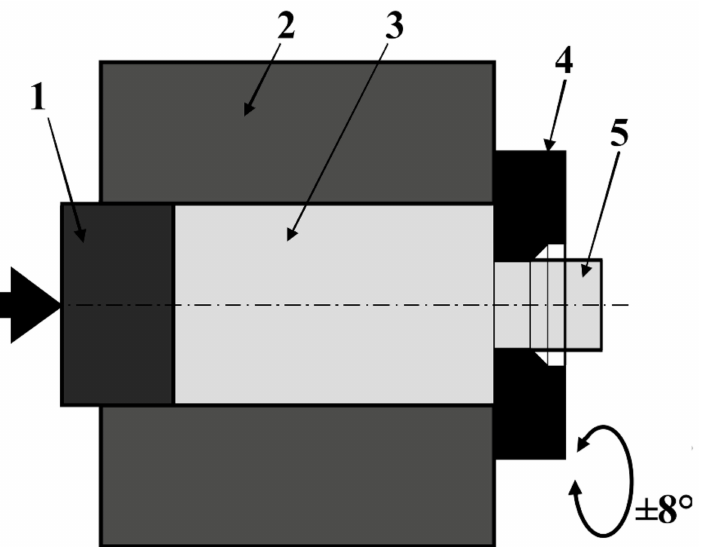
Figure 1. Scheme of KOBO extrusion method: 1—punch, 2—container, 3—billet, 4—reversibly rotating die, 5—extruded